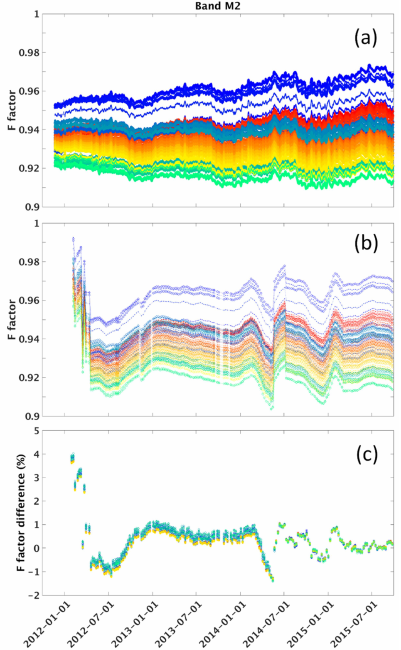
Figure A1. ( a ) VIIRS band M1 (412 nm, dual gain) radiometric calibration scaling coefficients (the F factors) derived by the automated calibration procedure; ( b ) the F factors used in the operational production of the VIIRS SDR; and ( c ) relative difference between the operational F factors and the reprocessed ones (used here as a baseline). Symbol legend is the same as in Figure 4.